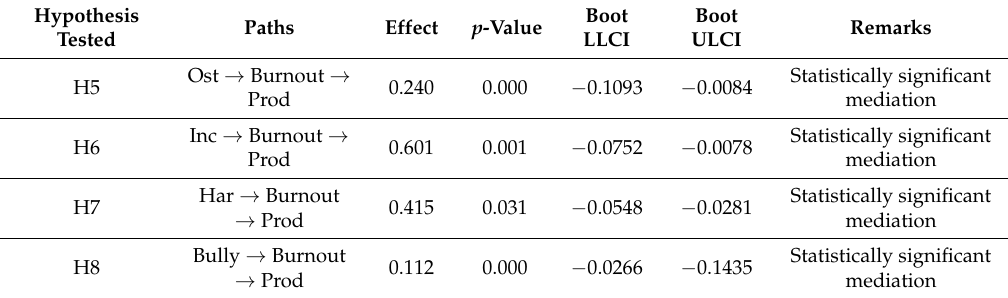
Table 7. Results of Indirect Effect (Mediation